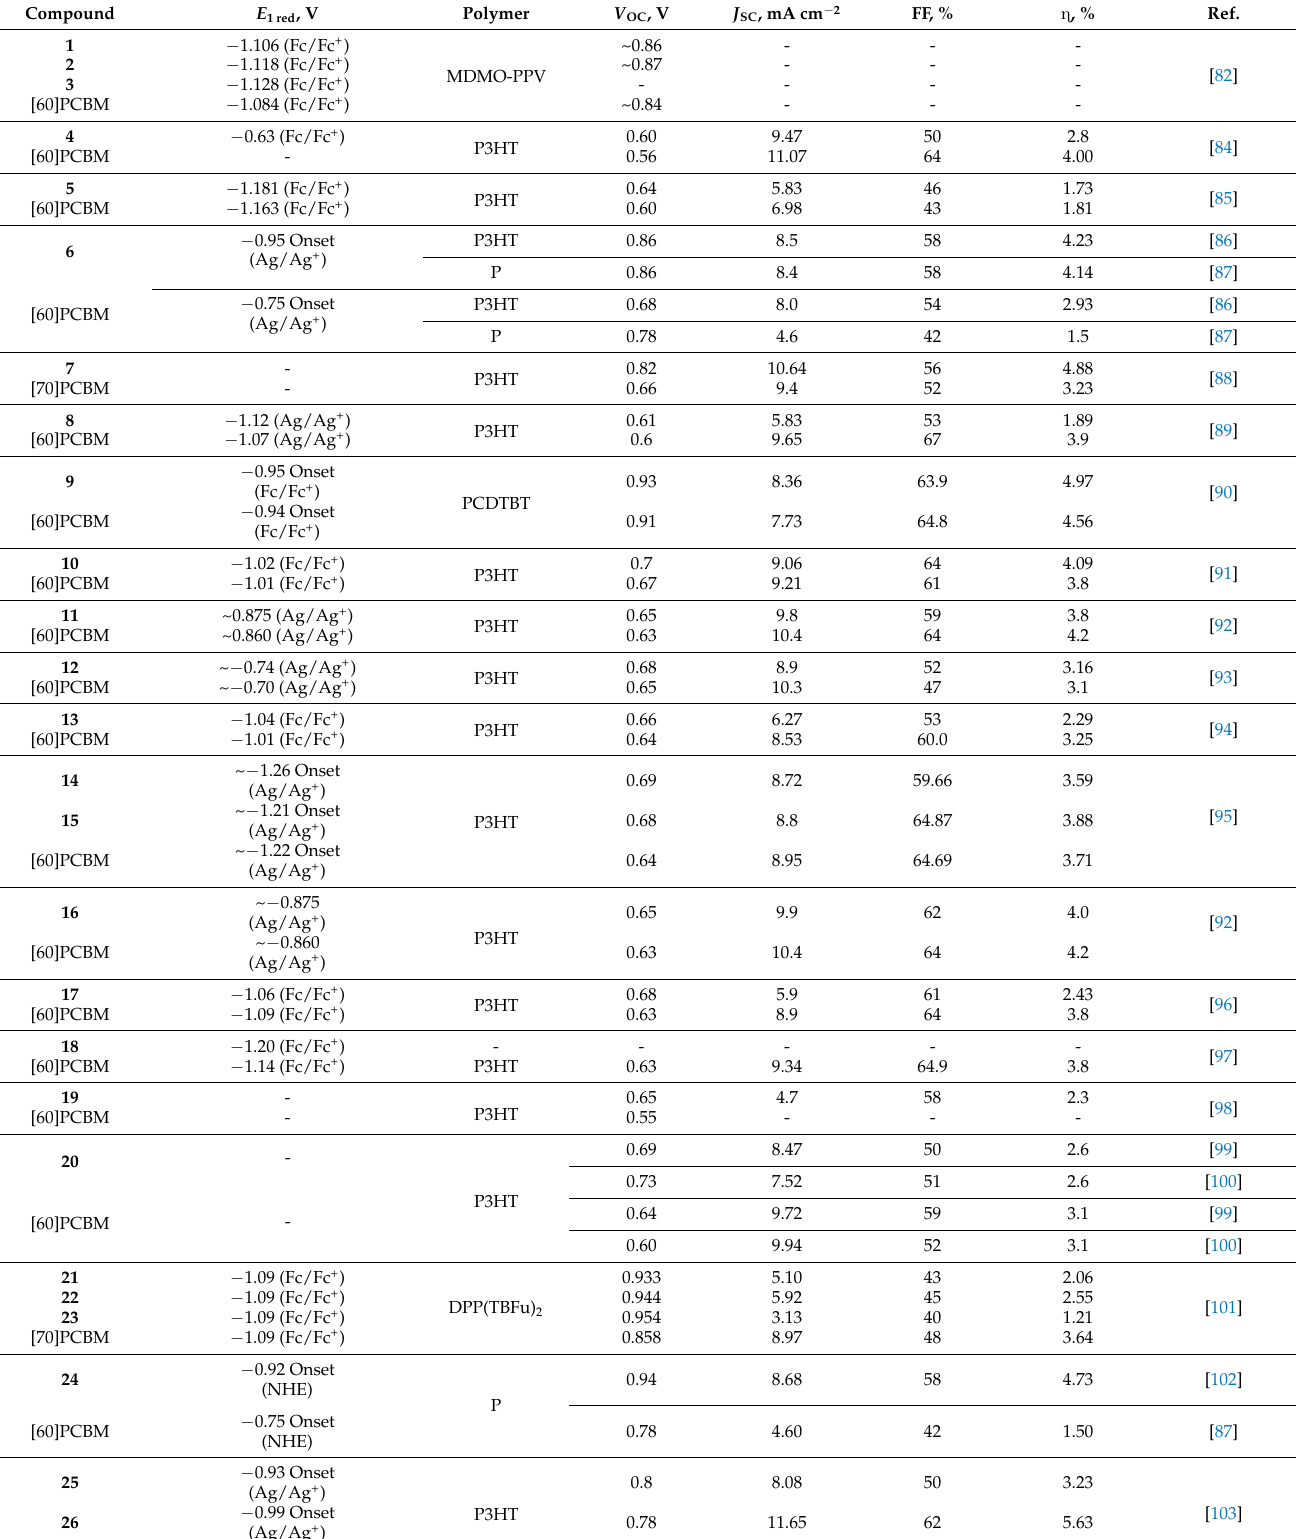
Table 1. First reduction potentials and characteristics of the solar cells based on cyclopropane fullerene